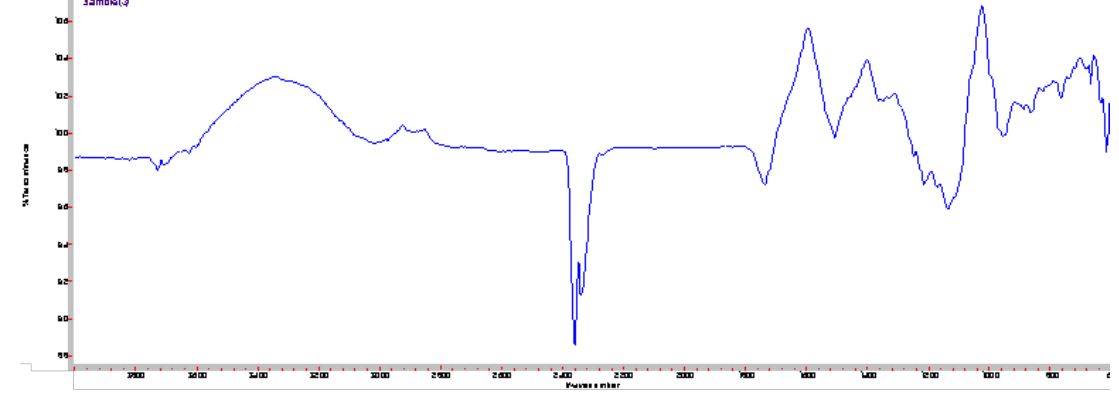
Fig. 4. IR of 2-aminoethansulfonic acid